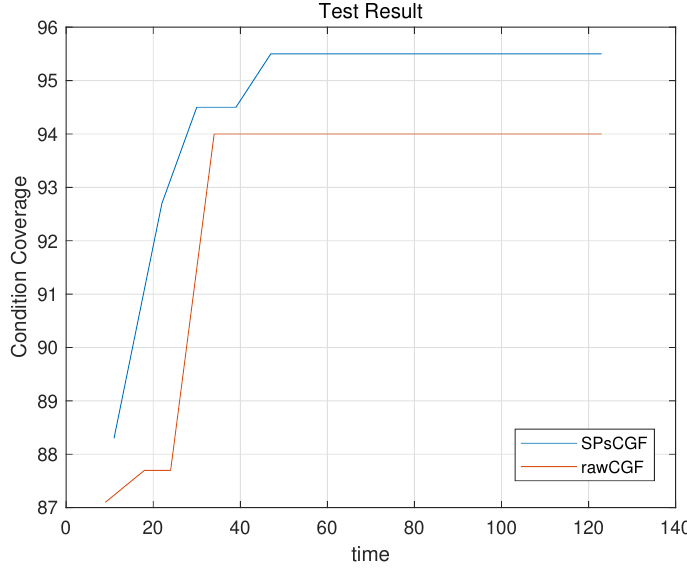
Figure 8. Coverage Diagram in MHI Model.